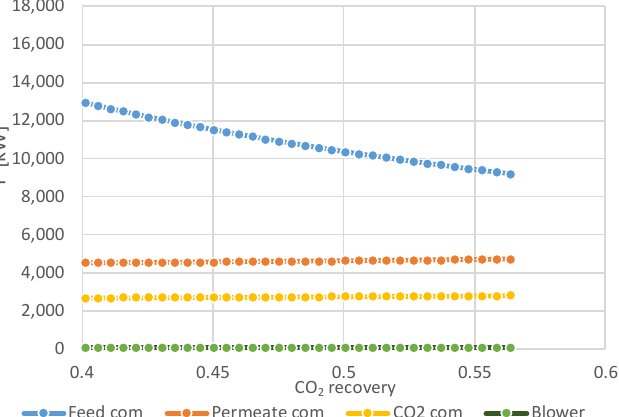
Figure 8. Breakdown of compression power as function of overall CO 2 recovery (at p feed = 2 bara, p perm = 0.3 bar, 2nd stage CO 2 recovery 0.7) .